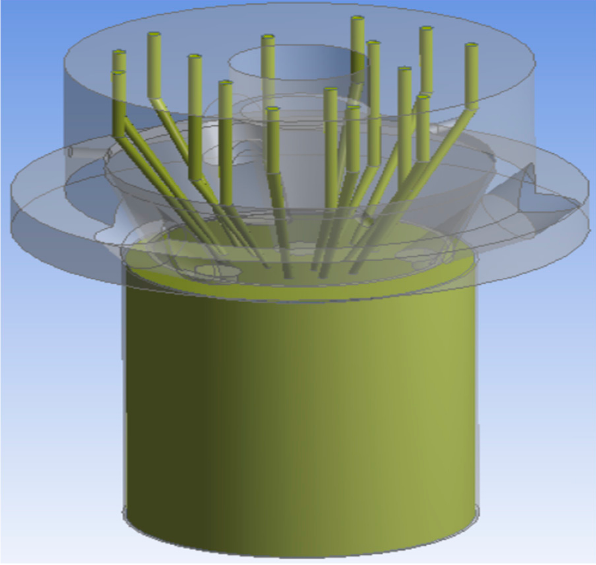
Figure 6. Simulation model.